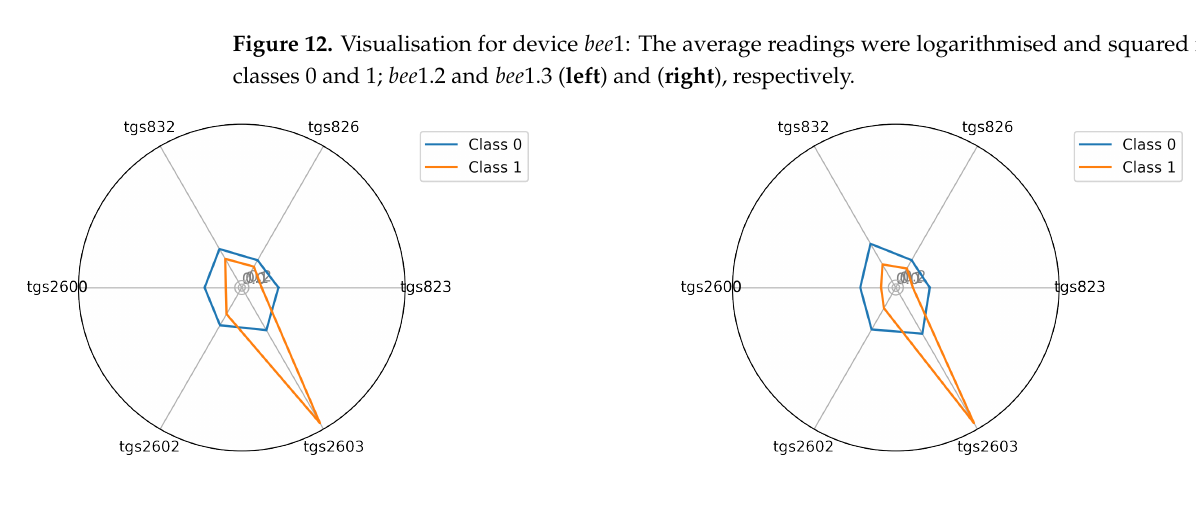
Figure 13. Visualisation for device bee 2: The average readings were logarithmised and squared in classes 0 and 1; bee 2.2 and bee 2.3 ( left ) and ( right ), respectively.